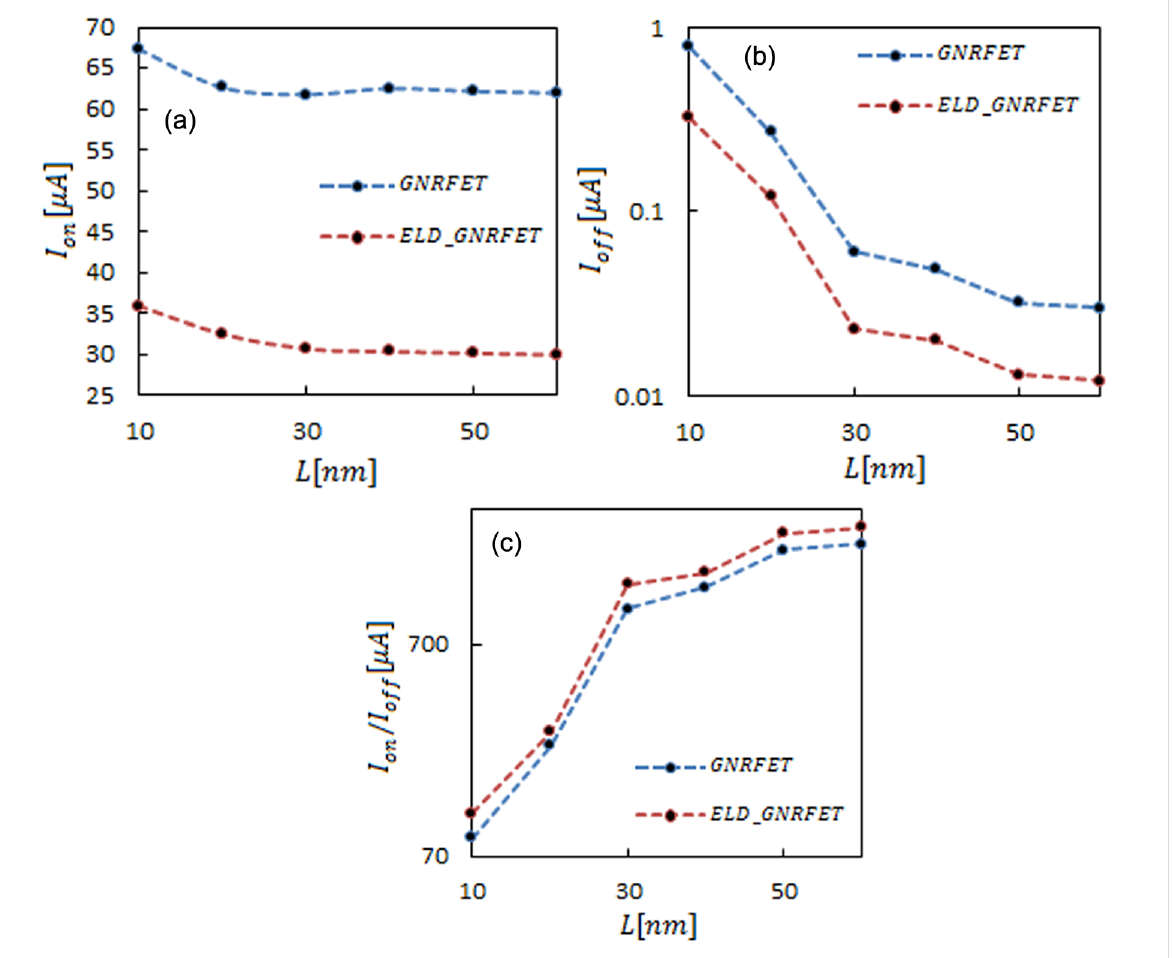
Figure 3: Channel length dependence of (a) on-current (b) off current (c) on/off current. The lines are a guide to the eye. The dashed blue line is for ELD-GNRFET and the dashed red line is for GNRFET.